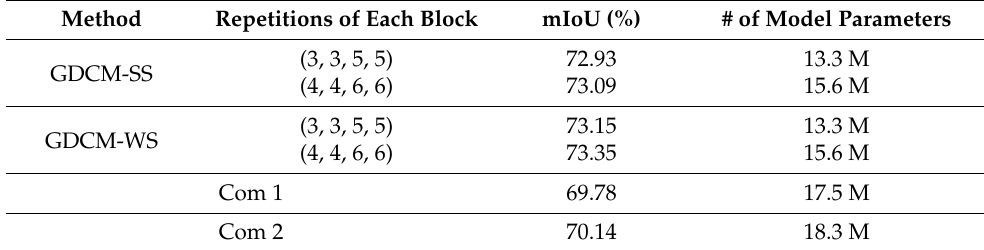
Table 5. Comparison of accuracy by model depth per